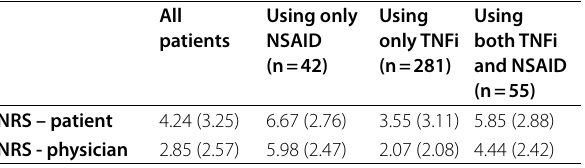
Fig. 2 AUC of patient’s (A, B) and physician’s (C, D) NRS for predicting disease activity according to BASDAI and ASDAS-CRP ASDAS-CRP Ankylosing Spondylitis Disease Activity Score, AUC area under the curve, BASDAI Bath Ankylosing Spondylitis Disease Activity Index, CI confi- dence interval, NRS numeric rating Table 3 Perception of disease activity